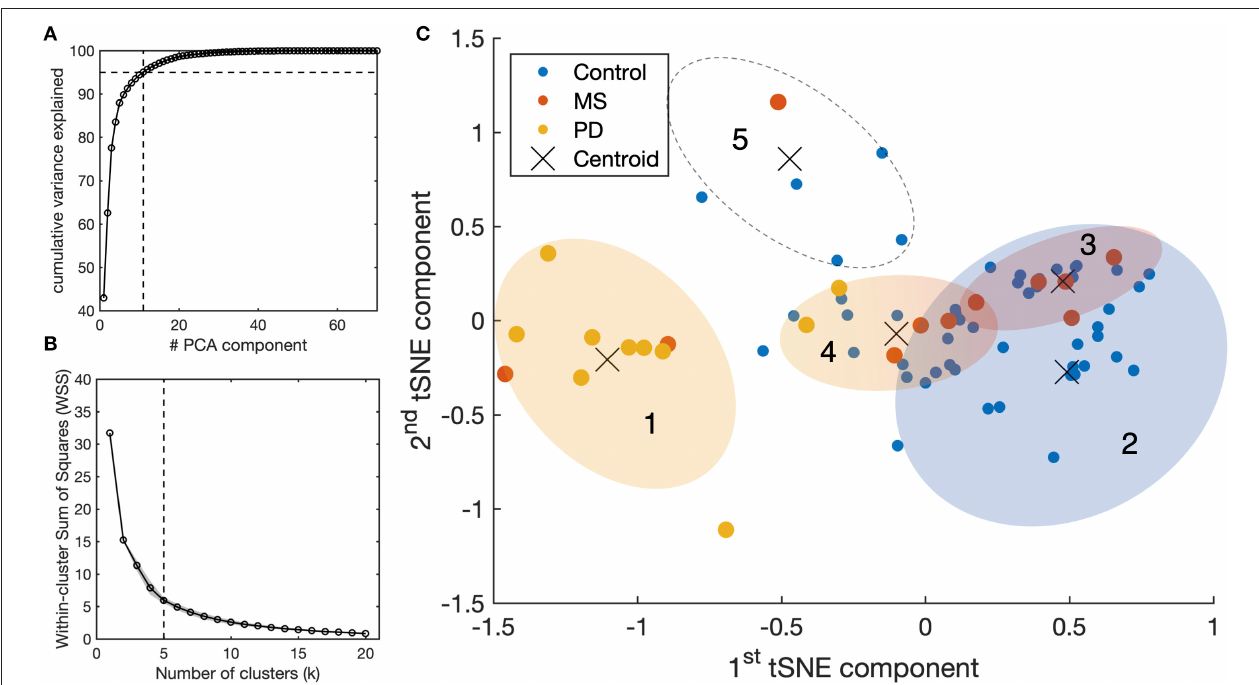
FIGURE 4 | Results of STP-based clustering analysis for the entire tested population. (A) Principle Component Analysis (PCA): all the spatio-temporal features available from SONDA (see Supplementary Material ) were used as an input for the PCA. The resulting components were processed with t-SNE to represent the high-dimensionality dataset into a lower-dimensionality space for clustering purposes. (B) Computation of the optimal number of clusters using the “elbow method” with the Within-clusters Sum of Squares (WSS) as a parameter. (C) Result of the k-means clustering algorithm ( k = 5) applied to the outcome components of